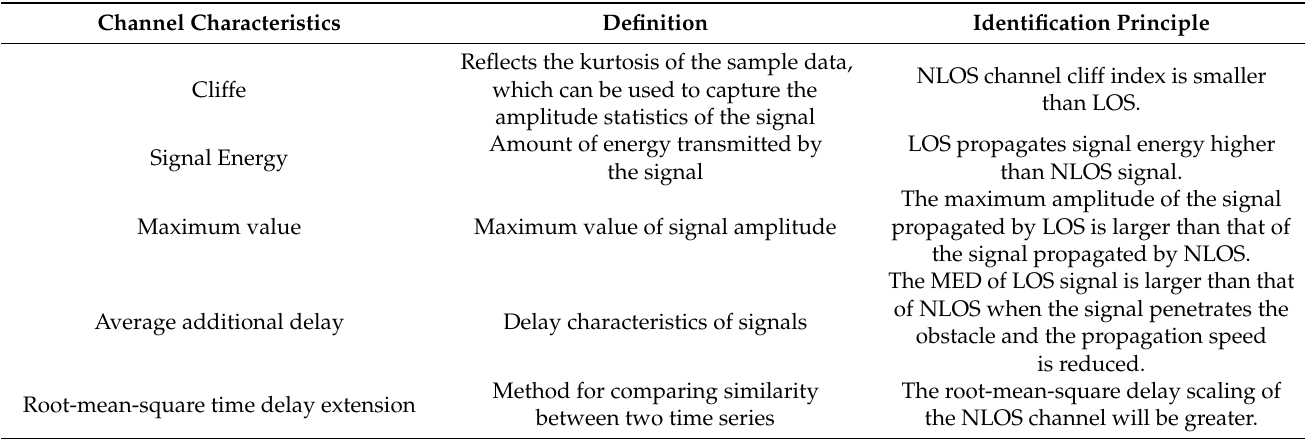
Table 2. Channel basic features definition and identification